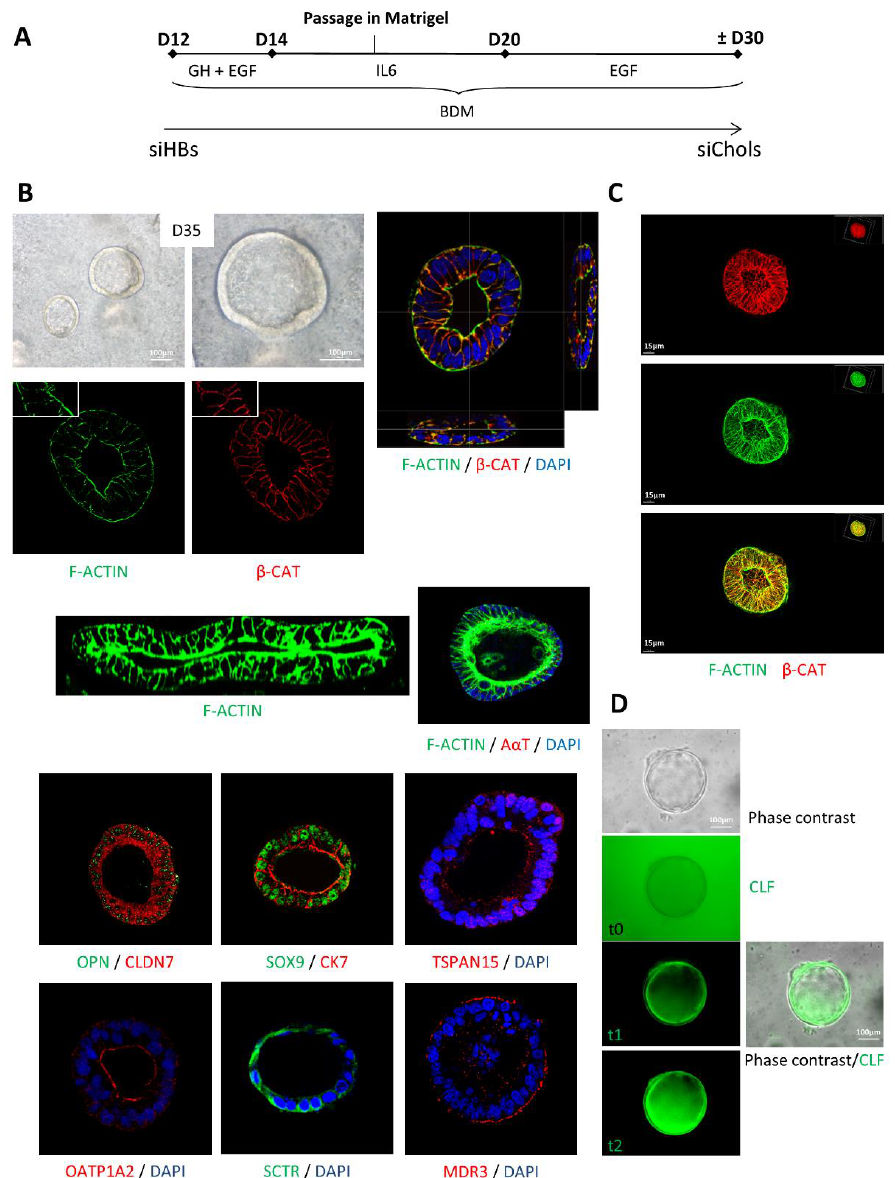
Figure 4. Formation of 3D siChol cysts. ( A ) Schematic representation of the protocol. ( B ) Cell morphology and immunostaining showing the expression of specific markers in cysts. Images were taken under the confocal microscope at 40X magnification. ( C ) 3D reconstruction of a siChol cyst using Imaris software. ( D ) Phase contrast and cholyl-lysyl-fluorescein (CLF) uptake showing pro- gressive fluorescent bile acid analogue transport into the siChol cysts via organic anion transporting polypeptides (OATPs). BDM: biliary differentiation medium.